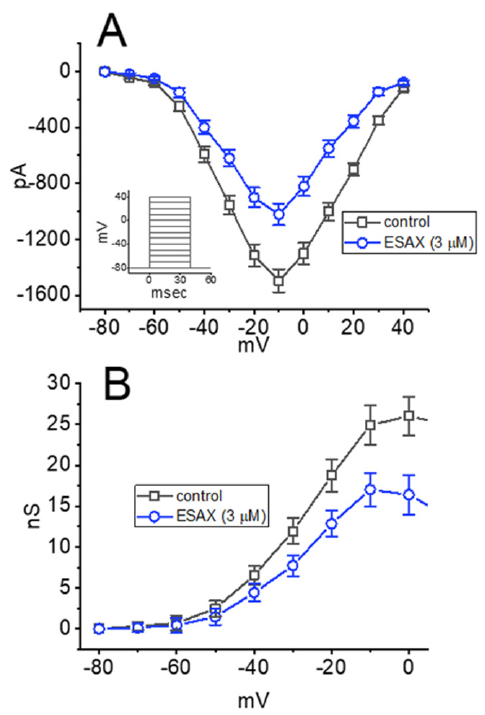
Figure 2. Effect of ESAX on current versus voltage ( I–V ) and conductance versus voltage relationships of I Na identified in GH 3 cells. ( A ) Mean I–V relationship of peak I Na taken without ( □ ) or with ( ○ ) the addition of 3 μ M ESAX (mean ± SEM; n = 7 for each point). Inset shows the voltage-clamp protocol delivered. ( B ) Mean conductance versus voltage relationship of peak I Na taken in the control period ( □ ) and during cell exposure ( ○ ) to 3 μ M ESAX (mean ± SEM; n = 7 for each point). Of notice, the conductance versus voltage relationship of the current between the absence and presence of ESAX did not differ, despite the decrease in maximal conductance of peak I Na .